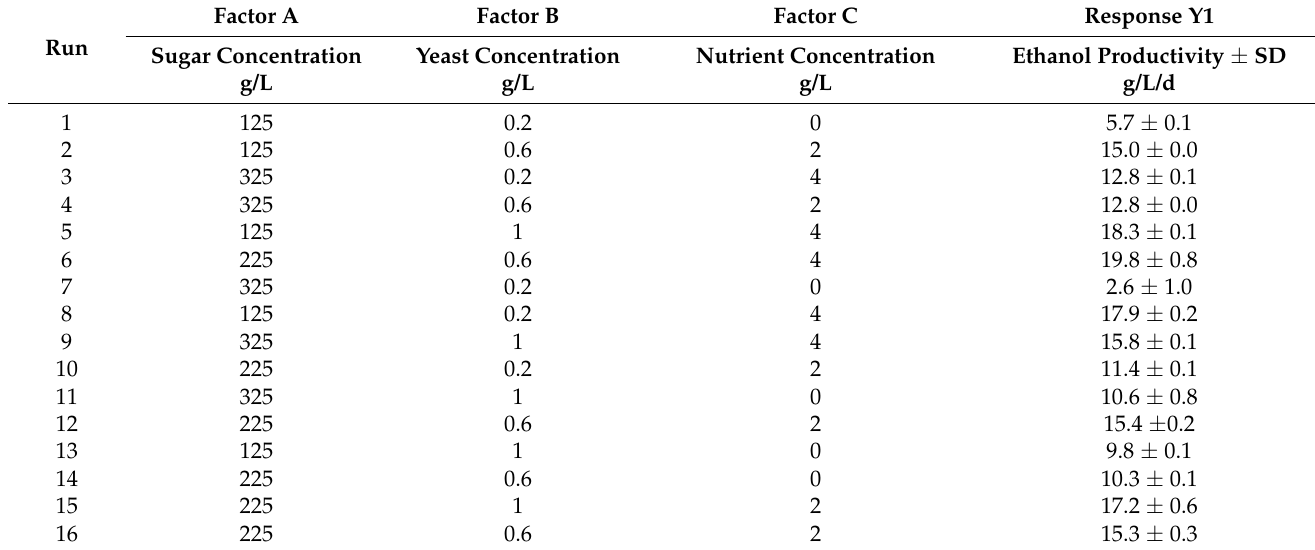
Table 3. Experimental design matrix of the CCD-RSM study presenting the different experimental lines as well as the investigated response generated during the molasses fermentation